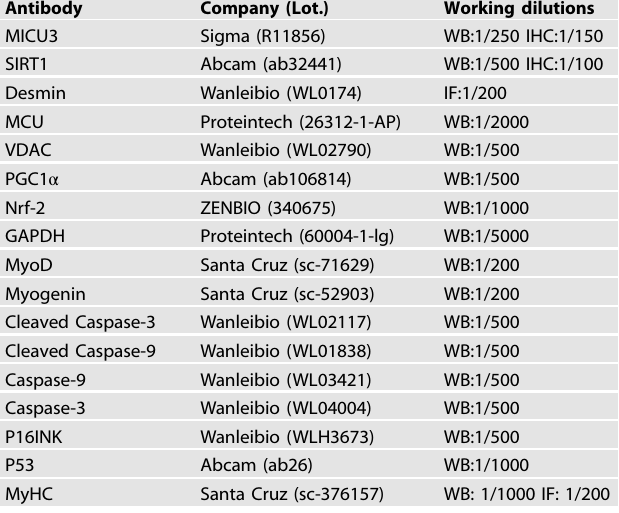
Table 2. Primary antibodies used for western blotting and